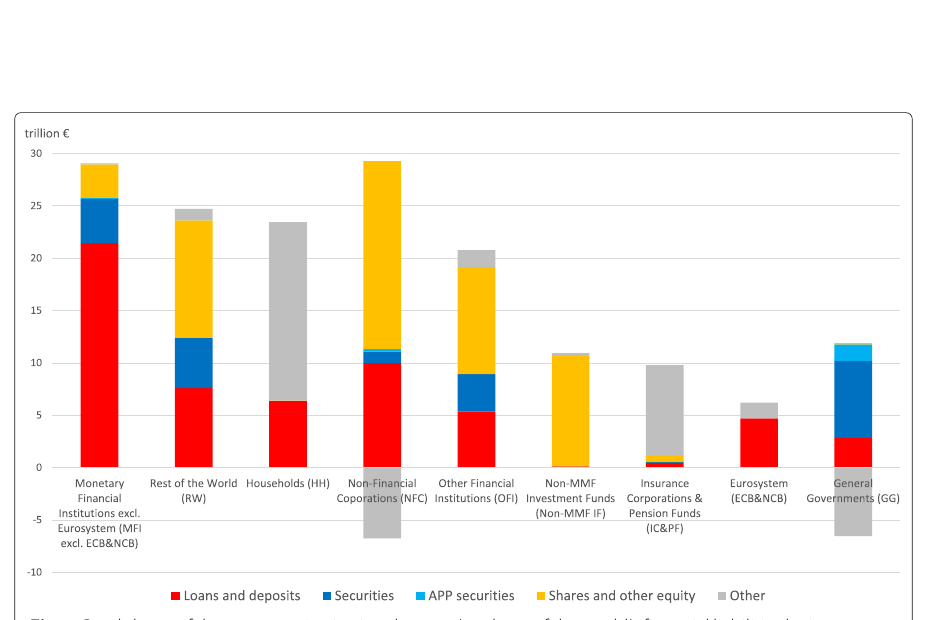
Fig.4 Breakdownoftheeuroareainstitutionalsectors’andrestoftheworld’sfinancialliabilitiesbyinstrument type; June 2017. Breakdown of the euro area institutional sectors’ and rest of the world’s financial liabilities by instrument type, i.e., short-term and long-term loans and deposits (in red), short-term and long-term private and public debt securities (in blue), APP securities (in light blue), listed, unlisted, and investment fund shares and other equity (in yellow), and other financial assets (in grey). The residual category “other” includes i) insurance and pension schemes (mostly, i.e., the 93.78%, issued by Insurance Corporations and Pension Funds), ii) other accounts receivable and financial derivatives (mainly, i.e., the 49.46%, issued by Non-Financial Corporations), and iii) euro area institutional sectors’ net worth. Data source: (European Central Bank